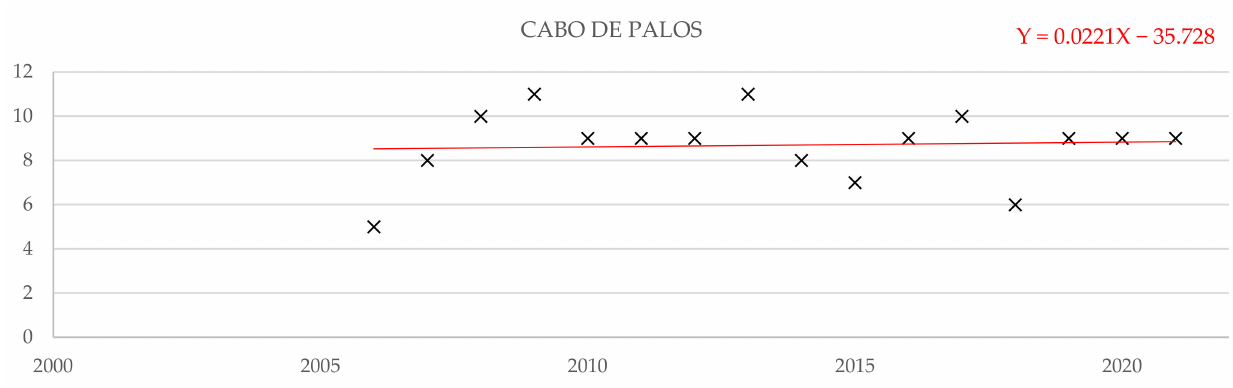
Figure 22. Number of times Hs has exceeded the threshold in Cabo de